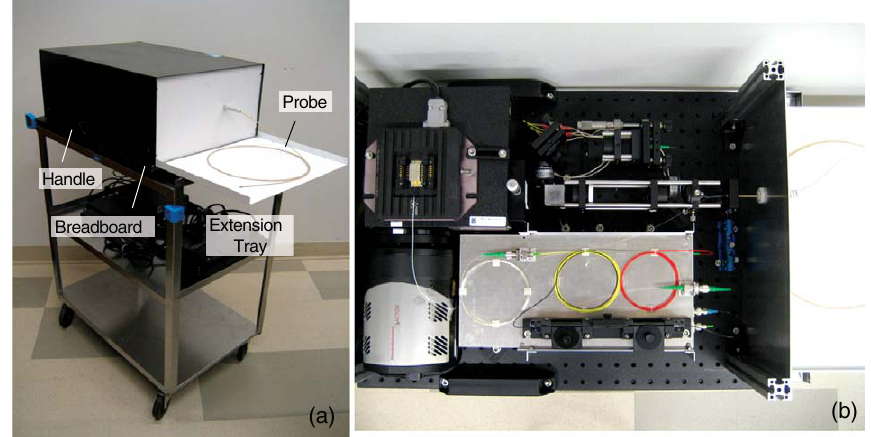
Fig. 4. Clinical a/LCI system. (a) Enclosed system on the cart with the extension tray installed. (b) System detail with top cover removed. Adapted from Ref.